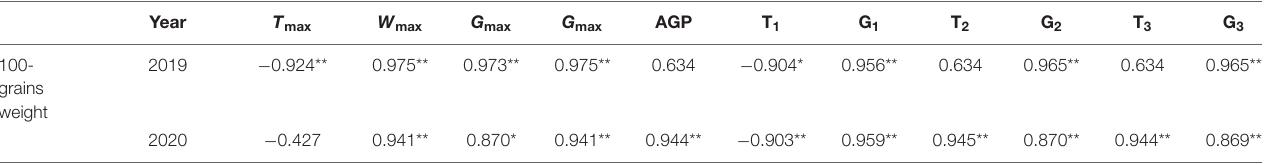
TABLE 5 | Pearson correlation of 100-grain weight and grain-filling parameters of maize